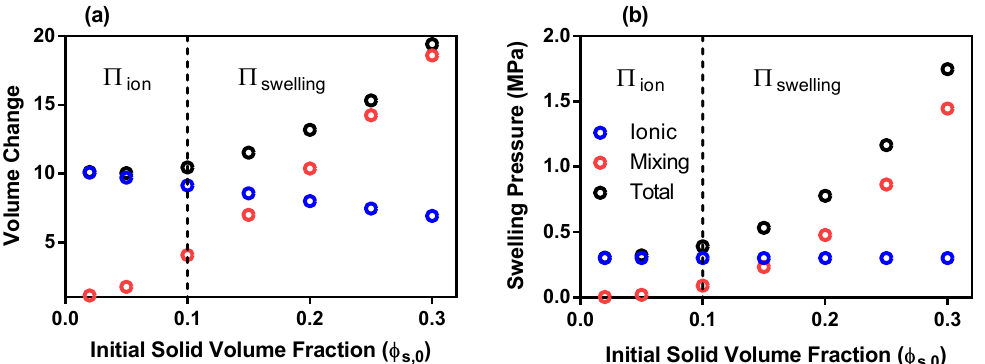
Figure 2. Univalent Solution: ( a ) Equilibrium volume change of the ionic, mixing and total swelling pressure models as a function of initial solid volume fraction ( b ) Initial swelling pressures of ionic, mixing and total swelling energies as a function of initial solid volume fraction. [ Π ion and Π swelling keys denote the swelling pressure model that should be used at each initial solid volume